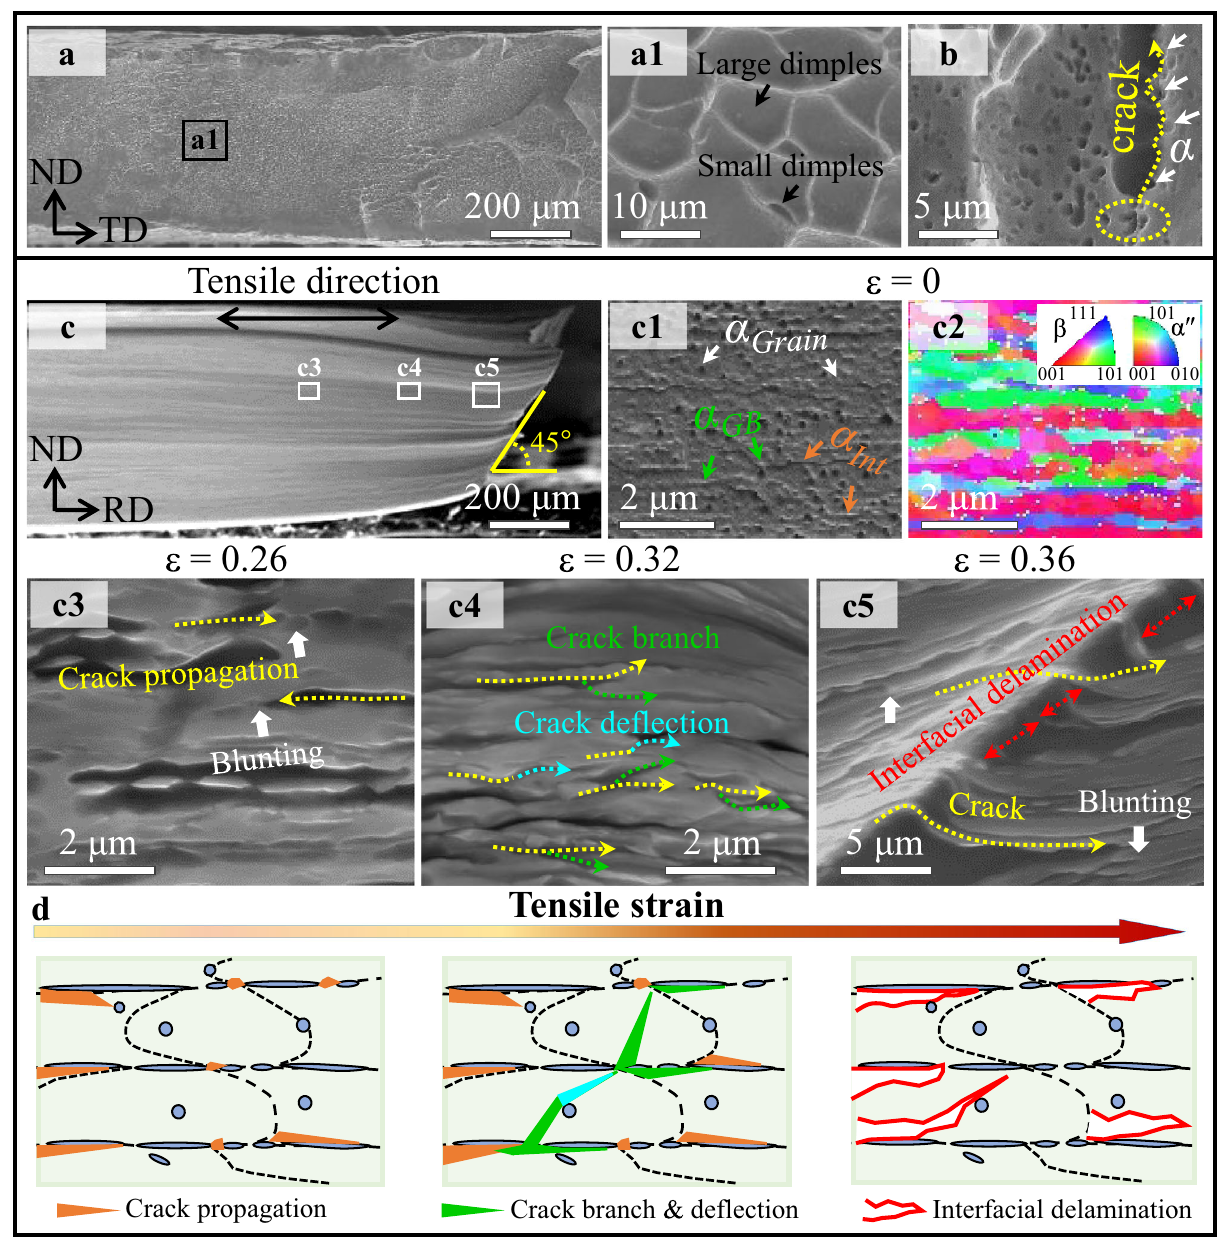
Fig. 5 | Fracture behavior and the underlying mechanism of HLS-0.43 β -Ti alloys. a An SEM image of the fracture surface of HLS-0.43 β -Ti alloys. a1 A mag- ni fi edimageofthefracturesurfaceshowsmassivedimples. b AnSEMimageshows that these cracks are initially nucleated at α / β layer interfaces. c An SEM image of the post-fractured HLS-0.43 sample along rolling direction. c1-c2 The SEM and corresponding EBSD images show the con fi gurations of undeformed α nanopre- cipitates at ε =0. c3 The SEM images show crack initiation and propagation along